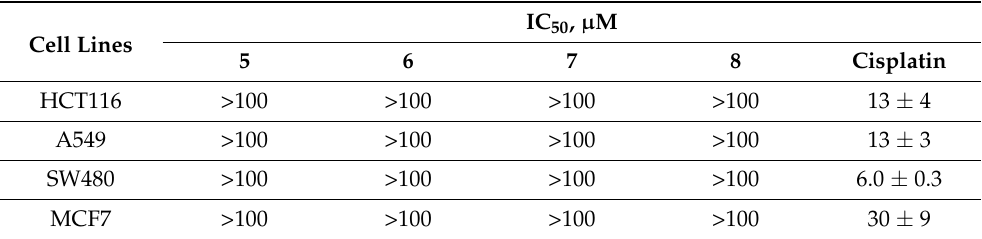
Table 3. Antiproliferative activity of 5 – 8 and cisplatin against human cancer